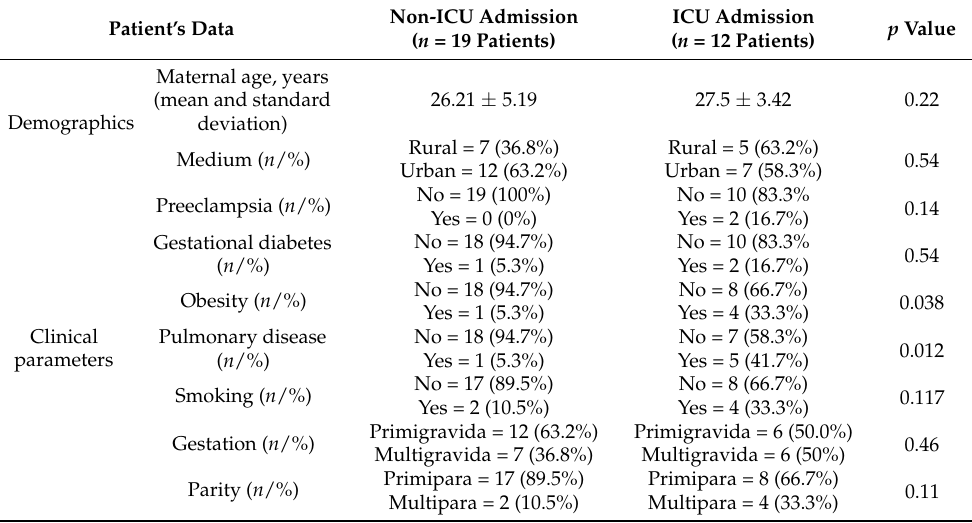
Table 1. A univariate analysis of the clinical characteristics for the patients included in our